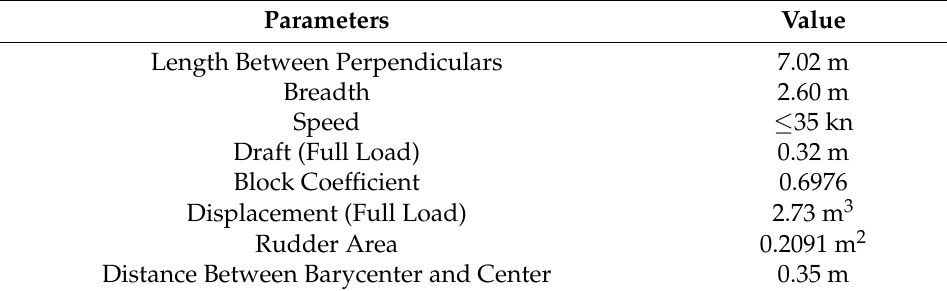
Table 1. Parameters of the “Lan Xin” USV.